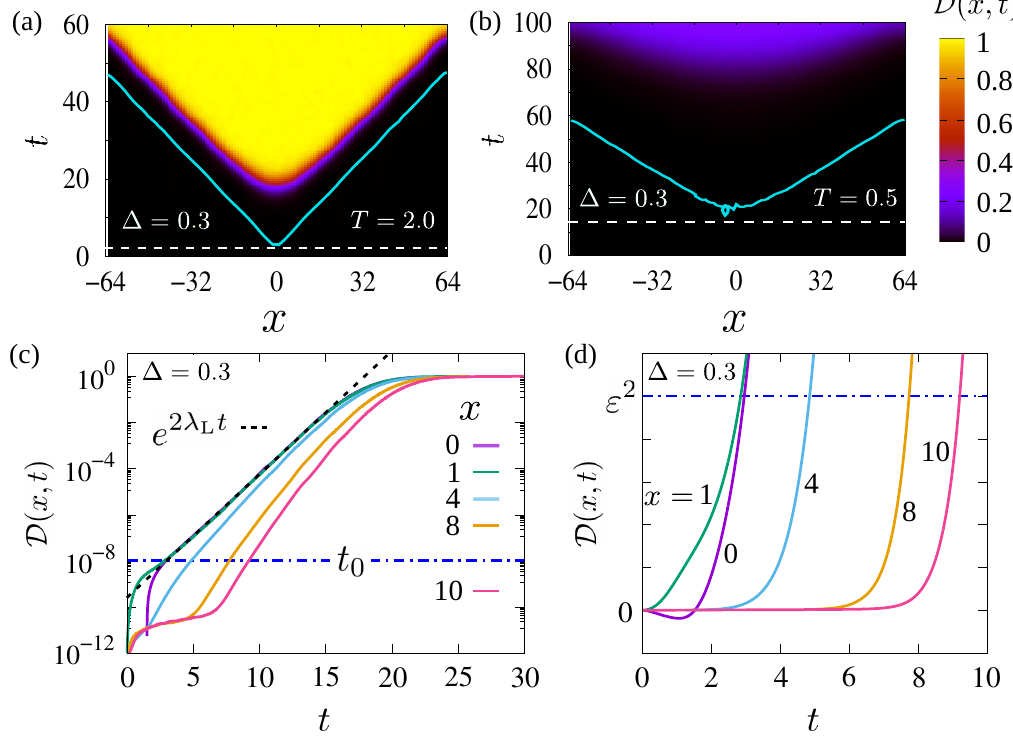
Figure 2: Spatio-temporal evolution of classical OTOC in 2d XXZ model: (a) and (b) show the growth and spread of initial perturbation at the origin for ∆ = 0.3 ) and T = 0.5 ( < T ) , respectively. The color at temperature T = 2.0 ( > T KT KT